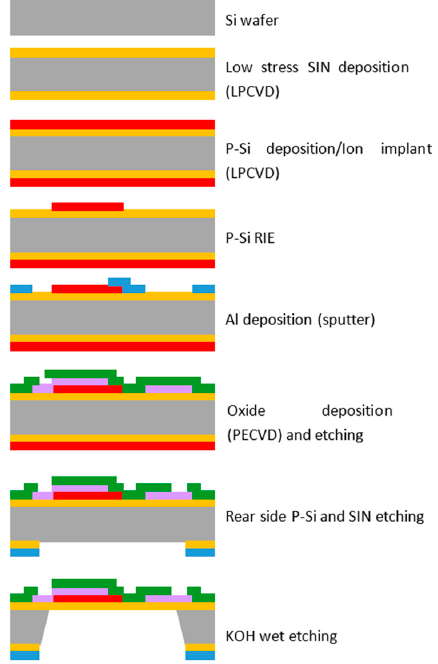
Figure 2. Manufacturing process of the MEMS 2D wind direction and wind speed sensor.